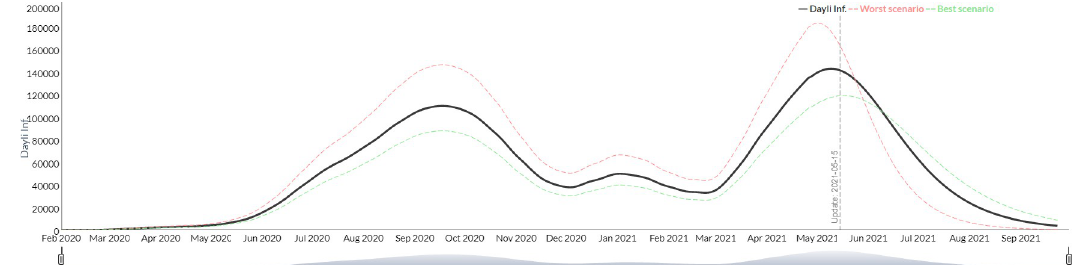
Fig 1. Simulation of the evolution of the new daily infected from July 2020 to September 2021 (Argentina).